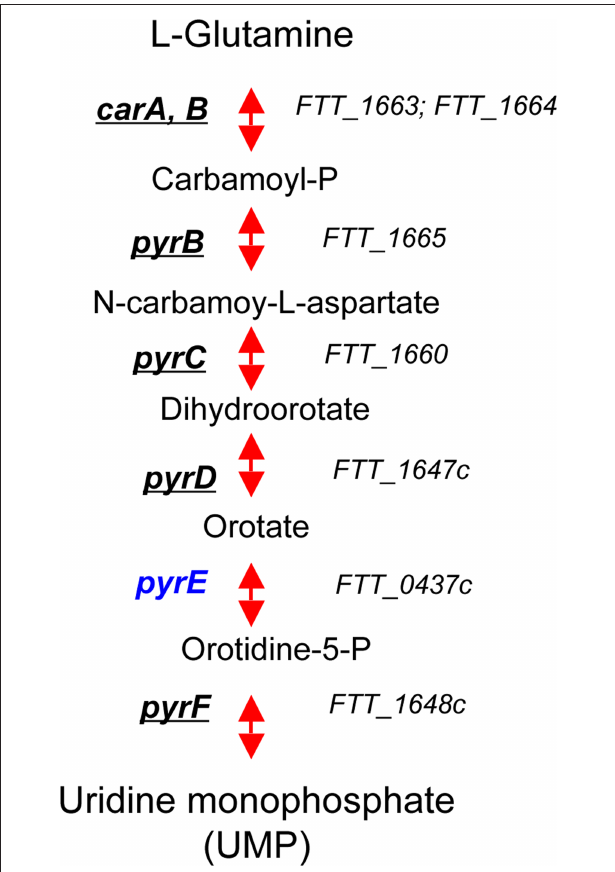
FiguRe 3 | The pyrimydine biosynthetic pathway. Genes that have been identified in genetic screens ( in vivo or in vitro ) are underlined. Genes that have not been hit in any screen are in